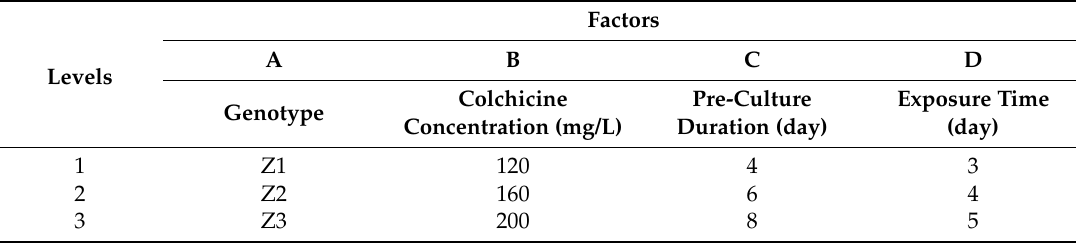
Table 1. Influencing factors and level